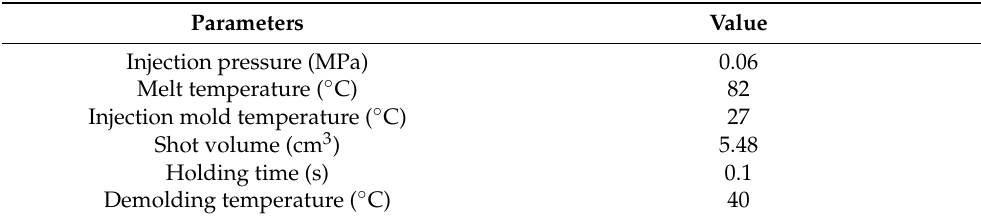
Table 2. Main numerical modeling parameters used in the numerical